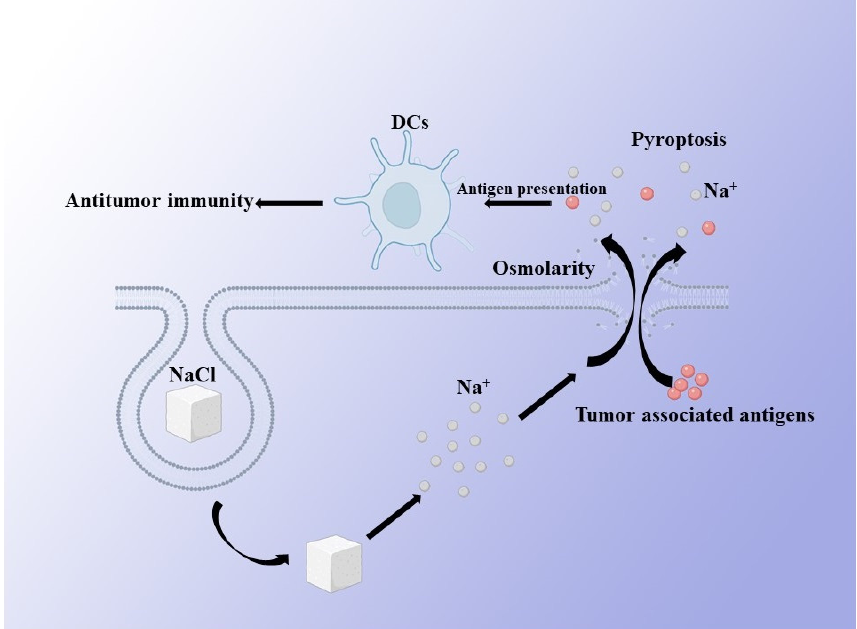
Figure 3. Schematic illustration of Na + —induced antitumor therapy. A large number of Na + ions being released by NaCl nanoparticles in cancer cells leads to a change in cell osmotic pressure and further induces pyroptosis of cancer cells. Pyroptosis can promote the presentation efficiency of tumor-associated antigens to DCs, thus enhancing the antitumor immunity.